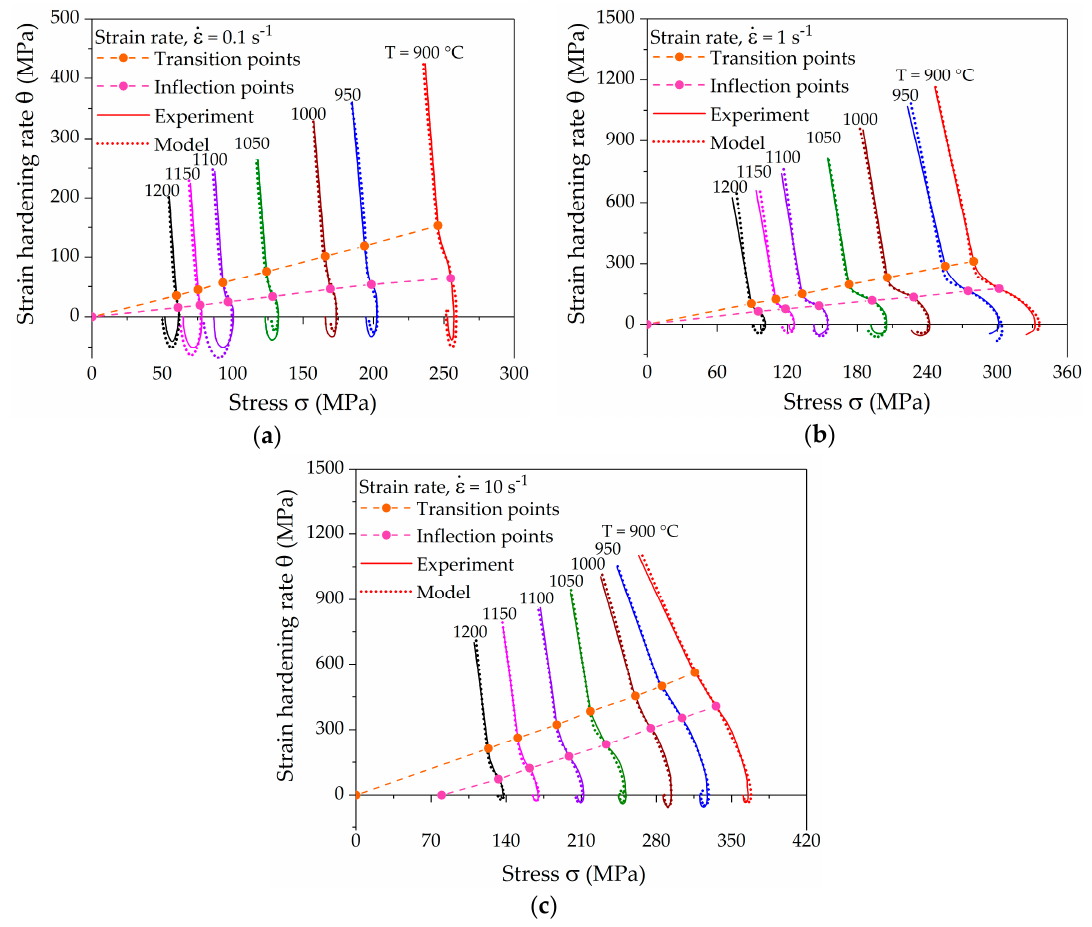
Figure 10. Fit of the computed strain-hardening rate curves with measured data from hot compression tests at different temperatures and strain rates of ( a ) 0.1 s − 1 ; ( b ) 1 s − 1 ; and ( c ) 10 s − 1 .